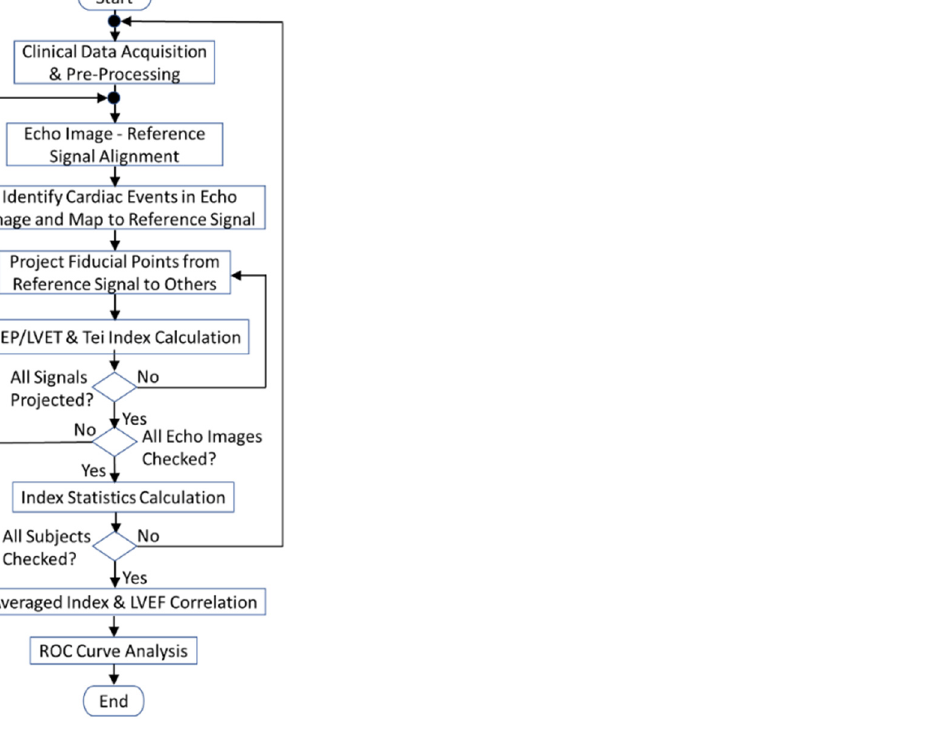
Figure 8. Programming flowchart of the DTW-based fiducial point detection and